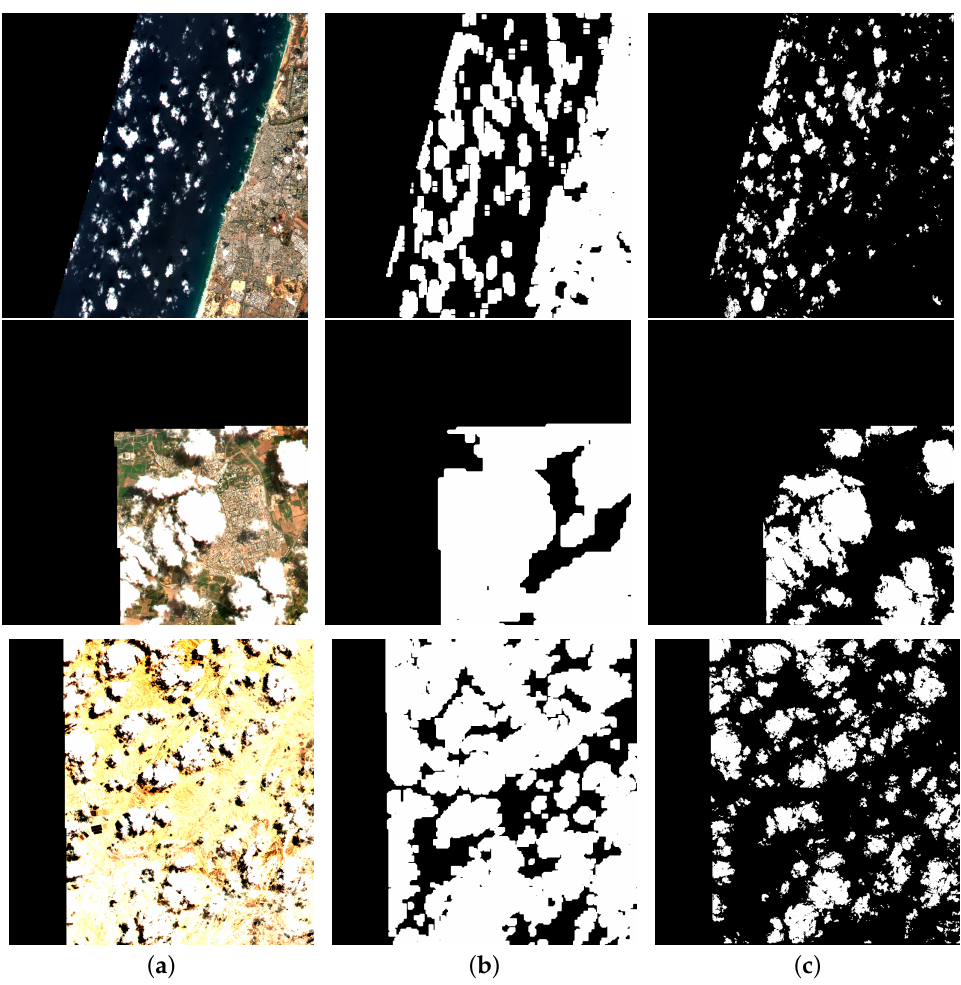
Figure 3. Comparison of the MAJA cloud mask and manual label: ( a ) RGB representations of patches of VEN µ S tiles; ( b ) MAJA cloud mask (except for the thinnest clouds and cloud shadows); ( c ) manually labelled cloud